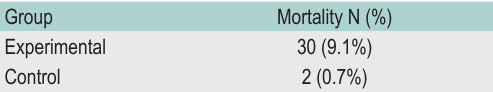
TABLE 5. Infants mortality in the experimental and control groups